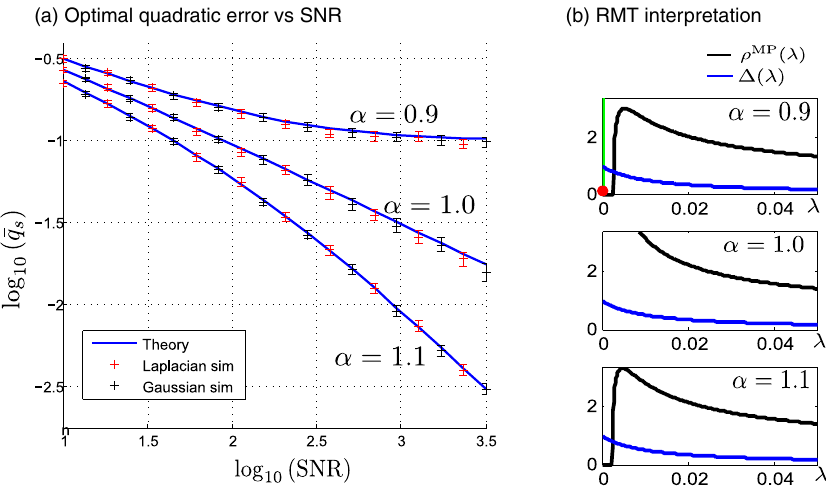
FIG. 5. A high SNR phase transition in optimal quadratic inference. (a) At large SNR, the MSE of optimal quadratic inference exhibits three distinct scaling regimes for α < 1 , α ¼ 1 , and α > 1 [see Eq. (23)], independent of the signal and noise distributions. For example, when α ¼ 0 . 9 < 1 , ¯ q Quad s approaches a constant, whereas when α ¼ 1 or α ¼ 1 . 1 > 1 , ¯ q Quad s approaches 0 as SNR − 1 = 2 or SNR − 1 , respectively. The theoretical curves (blue) match numerical experiments (error bars) for a finite-sized problems ( N and P vary with ffiffiffiffiffiffiffi p N ¼ α P and NP ¼ 300 ), where the error bars reflect the standard deviation across 80 trials using both signal and noise either Gaussian (black) or Laplacian (red) distributed. (b) The behavior of the MP density (black) in Eq. (26). For α ≠ 1 , the nonzero continuous part of the density exhibits a gap at the origin, whereas for α ¼ 1 , the gap vanishes and the distribution diverges at the origin. For α < 1 , there is an additional δ function at the origin (green bar) with weight 1 − α (red dot). The blue curve shows the function Δ ð λ Þ ¼ ð 1 þ λ · SNR Þ − 1 appearing in the integral for ¯ q Quad s in Eq. (27), for the value SNR ¼ 100